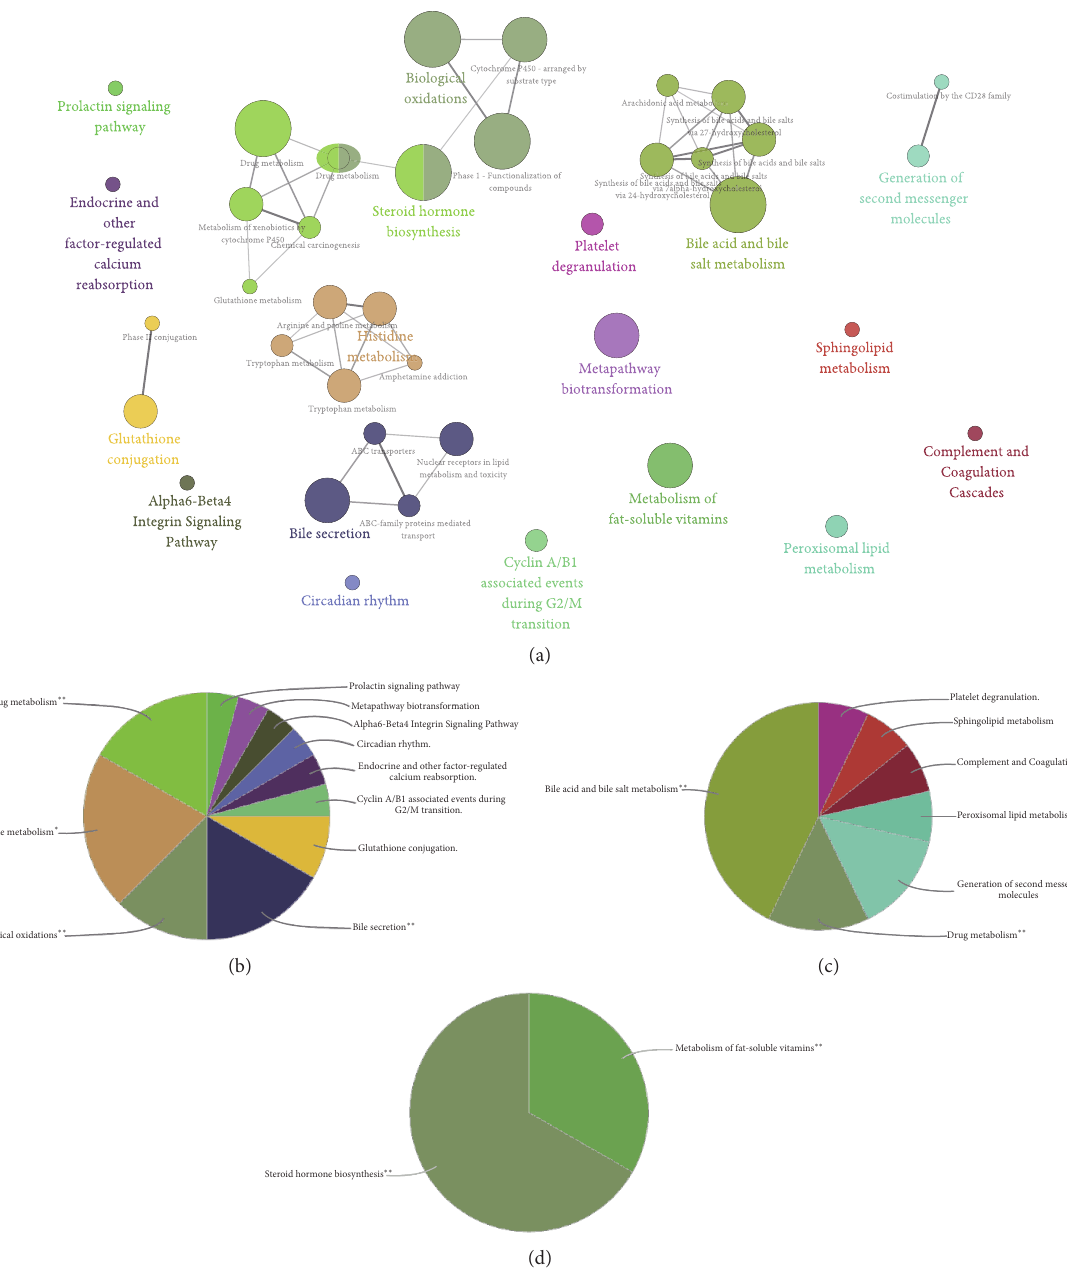
Figure 4: Functionally grouped network of enriched pathway categories was generated for the upregulated and downregulated genes. Pathway terms are represented as nodes. Functionally related groups partially overlap (a). The node pie charts represent pathway analyses for upregulated genes (b) and downregulated genes (c) and uncertain genes (d). of DN remains highly complex to be fully understood.